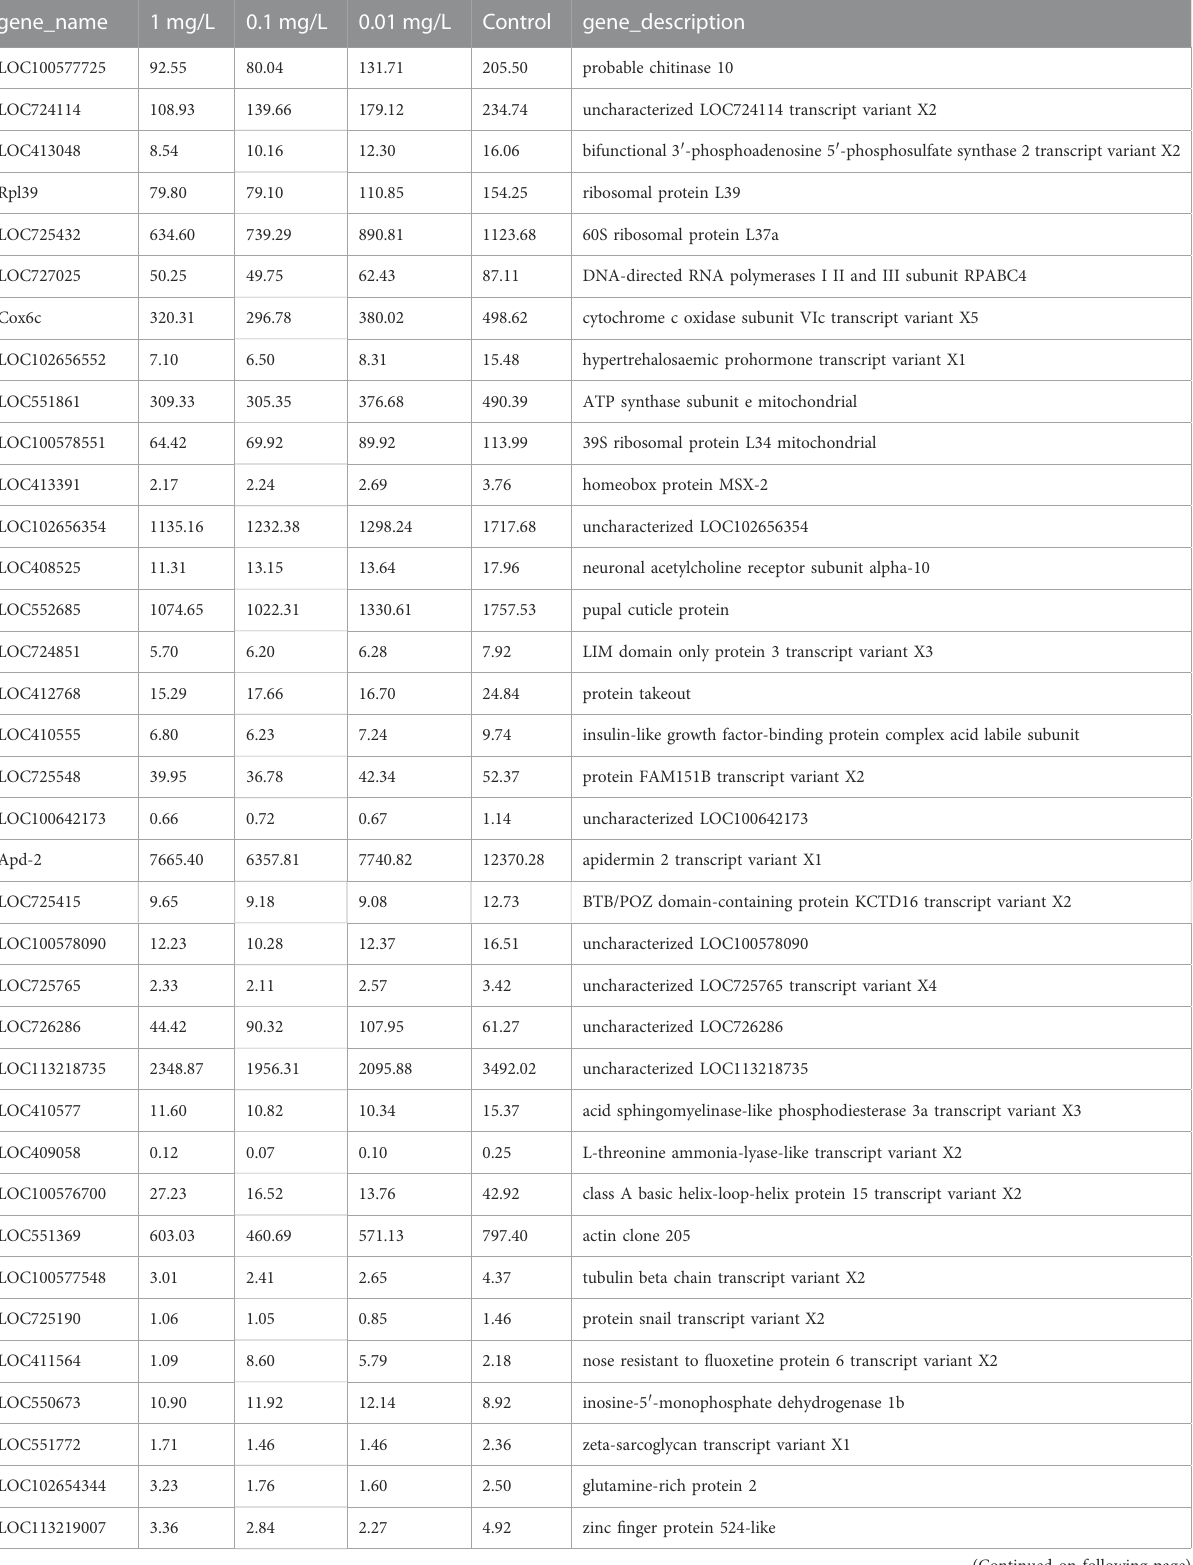
TABLE 2 The fragments per kilobase of exon per million mapped fragments (FPKM) of common DEGs between treated groups and control